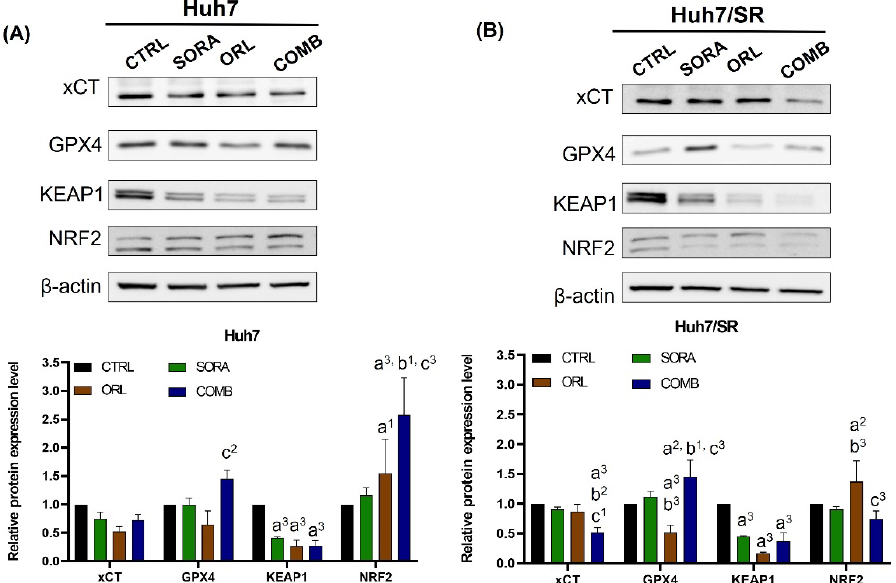
Figure 6. Combination treatment of sorafenib and orlistat altered expressions of ferroptosis-related proteins in Huh7 and Huh7/SR cells. Protein expression changes were detected by Western blot in ( A ) Huh7 and ( B ) Huh7/SR cells after treatments, which caused similar changes in xCT, GPX4, and KEAP1 expressions but had different effects on NRF2 expression in both cell lines. Significantly, orlistat and combination treatment decreased KEAP1 levels in both cell lines; both treatments only elevated NRF2 level in Huh7 cells but had little effect on Huh7/SR cells. a, compared to Control; b, compared to Sorafenib; c, compared to Orlistat; 1 p < 0.05; 2 p < 0.01; 3 p < 0.001.